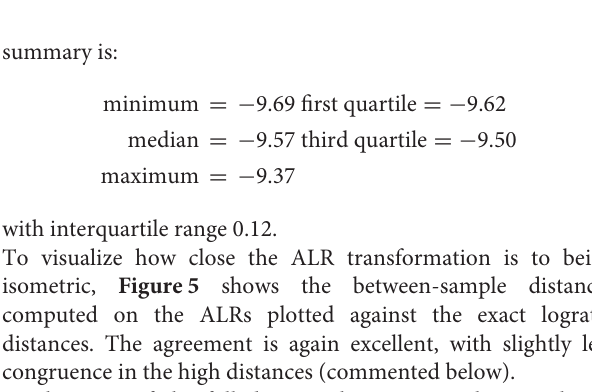
FIGURE 5 | Between-sample distances for the Mice data based on the ALRs with reference transcript 1,179 vs. the exact logratio distances, corresponding to the Procrustes correlation of 0.9974. The number of pairs of distances plotted 28 27 / 2 = × =